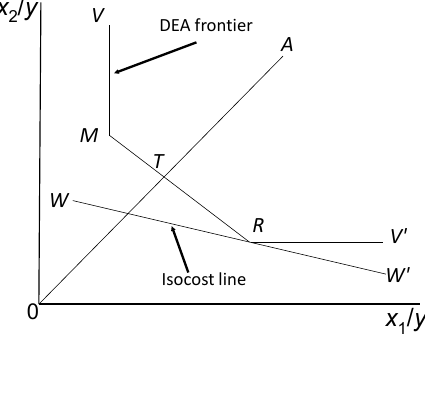
FIGURE 1: Two-input single-output DEA frontier Source: Coelli, et al.,